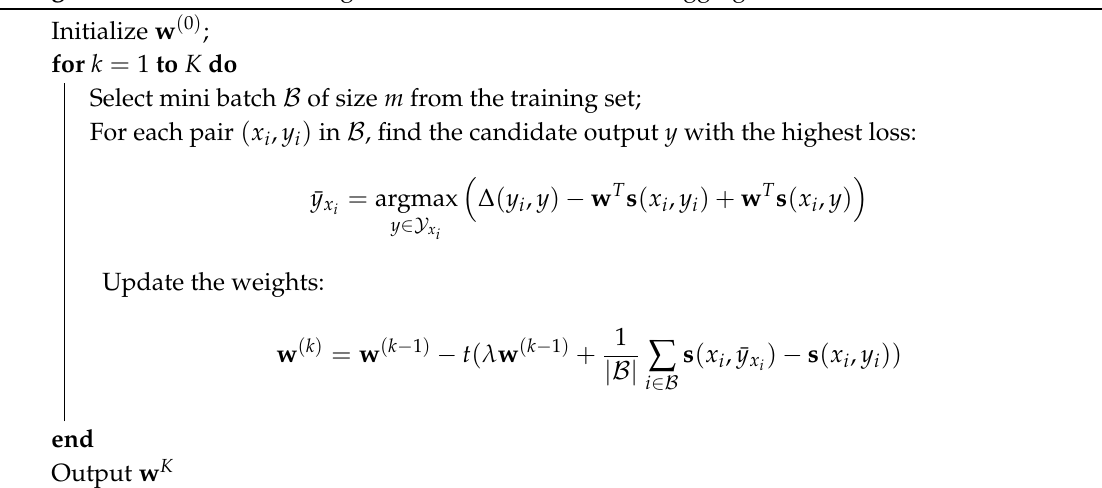
Algorithm 1: Mini-batch subgradient descent for the score aggregation.